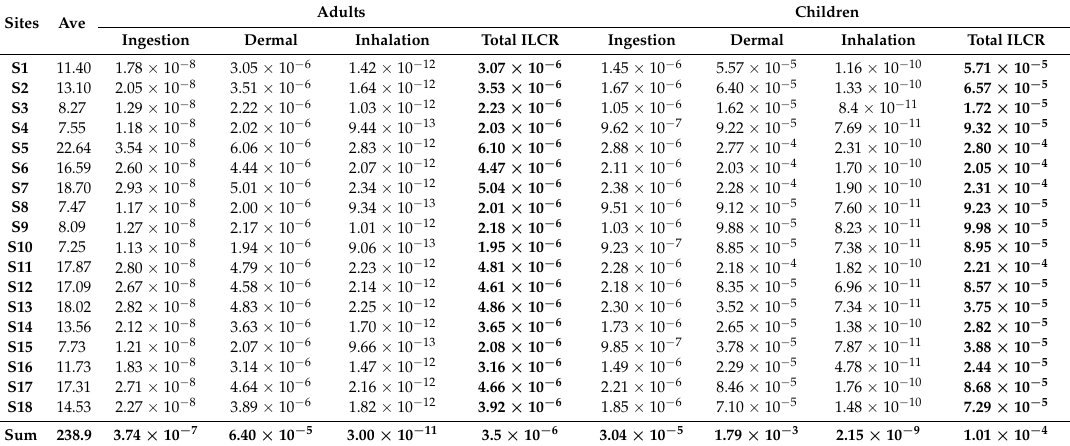
Table A3. Incremental lifetime cancer risk (ILCR) values for the samples collected from the Huangpi